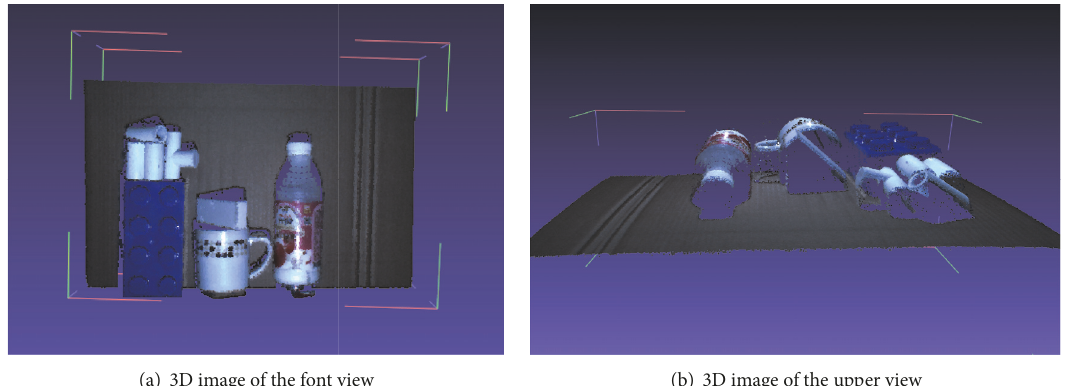
Figure 8: 3D reconstruction result with multiple objects (a cup, bottle, small box, lego box, and some plastic pipes), the bottle and cup are with high reflecting